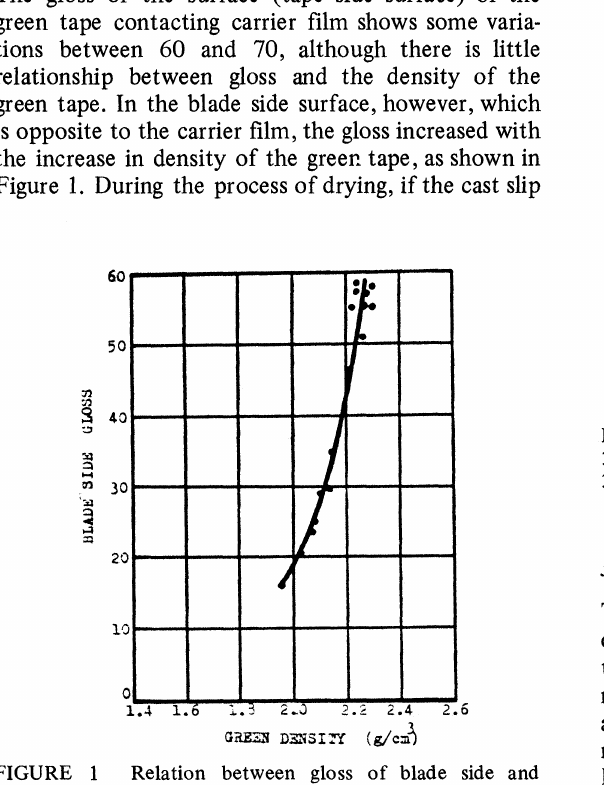
FIGURE Relation between gloss of blade side and density of green tapes.